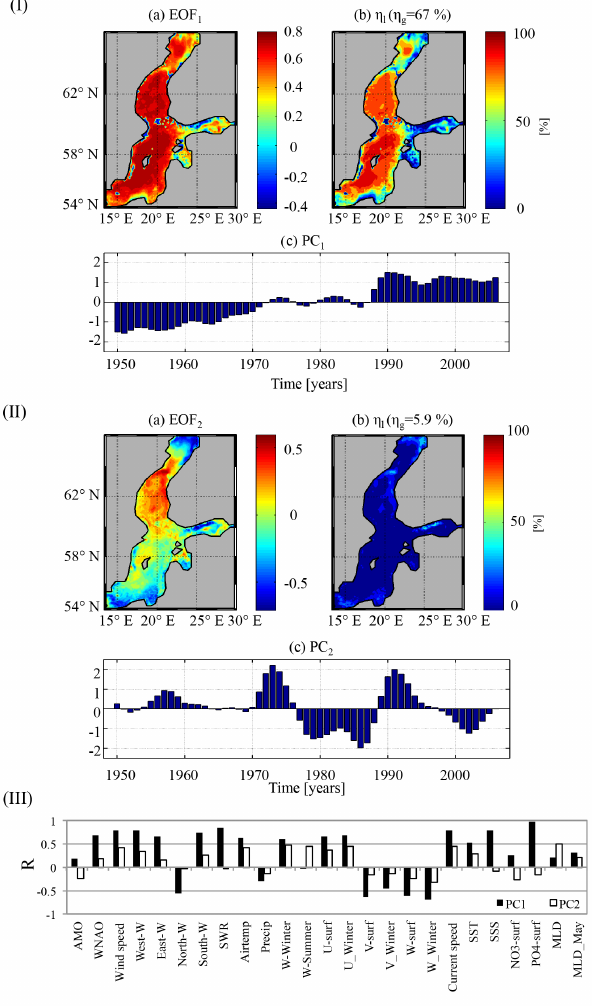
Figure 10. (I and II) (a) First and second empirical orthogonal functions for annual mean primary production in the Baltic Sea (1948–2008); (b) local explained variance for the pattern for the corresponding EOF; (c) principal component (time variation) of the corresponding EOF. (III) Absolute values of the correlation coeffi- cient between the principal components (PC1 & PC2) and an envi- ronmental variable stated on the x